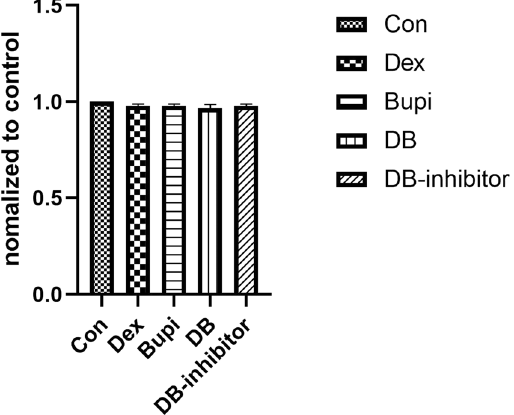
Figure 1: CCK - 8 assay for detection of cell viability. Data were expressed as mean ±